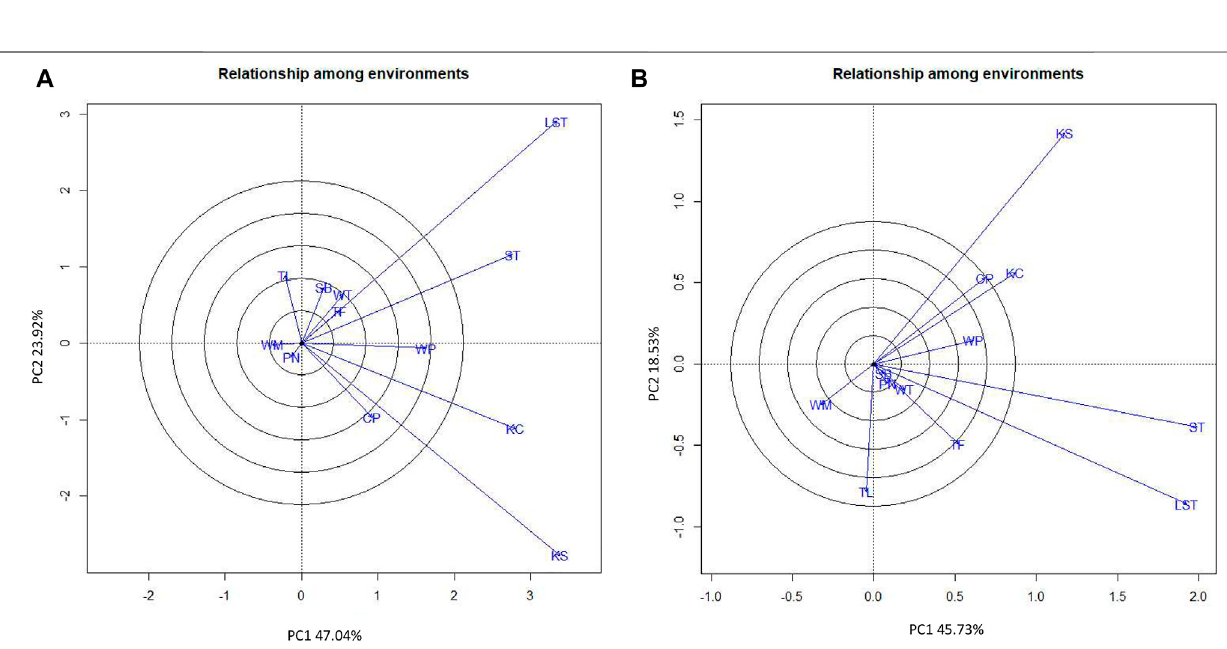
Frontiers in Genetics |